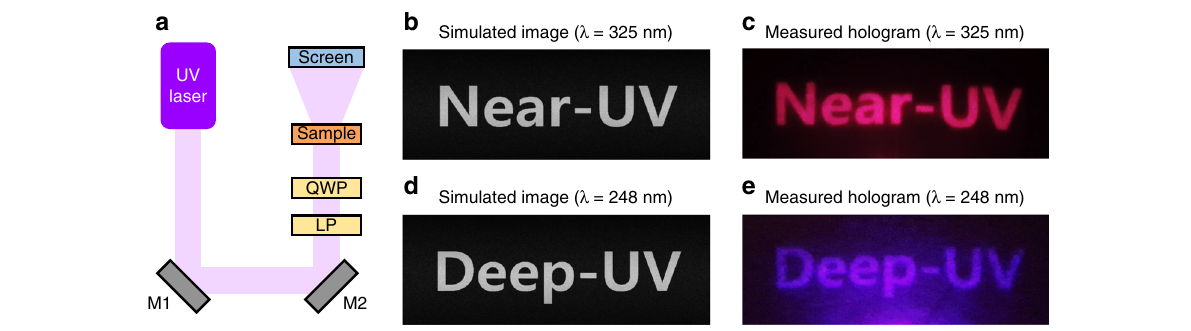
Fig. 4 Demonstration of the UV metahologram. a Optical setup for ZrO 2 nano-PER based UV metahologram (UV laser: HeCd laser for 325 nm, KrF laser for 248 nm; LP: linear polarizer; QWP: quarter-wave plate; Screen: UV sensor card). b Simulated and c measured image of the target hologram designed for λ = 325 nm. d Simulated and e measured image of the target hologram designed for λ = 248